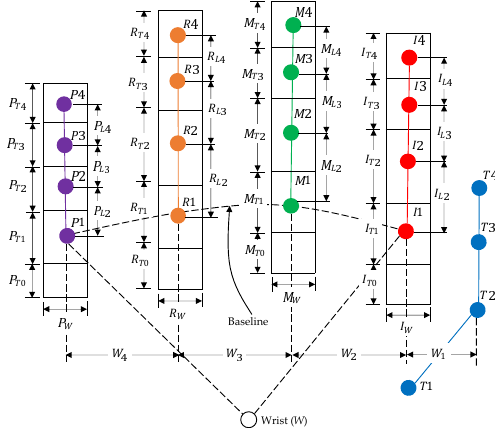
Figure 13. Template range